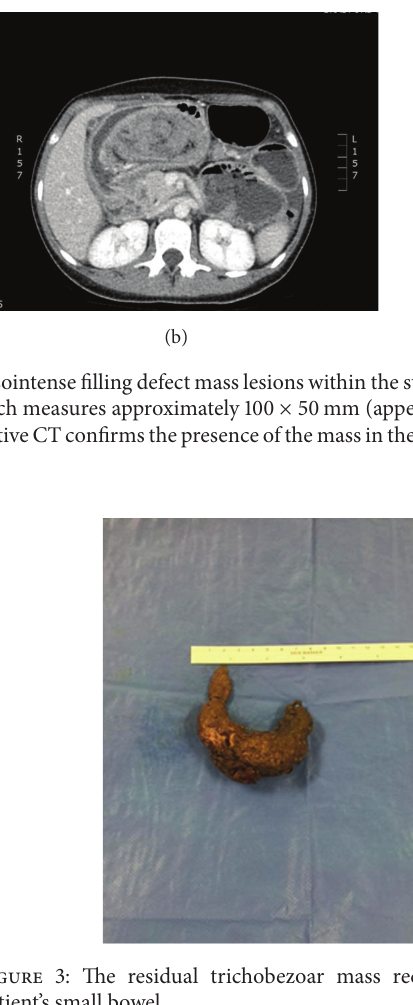
patient’s small